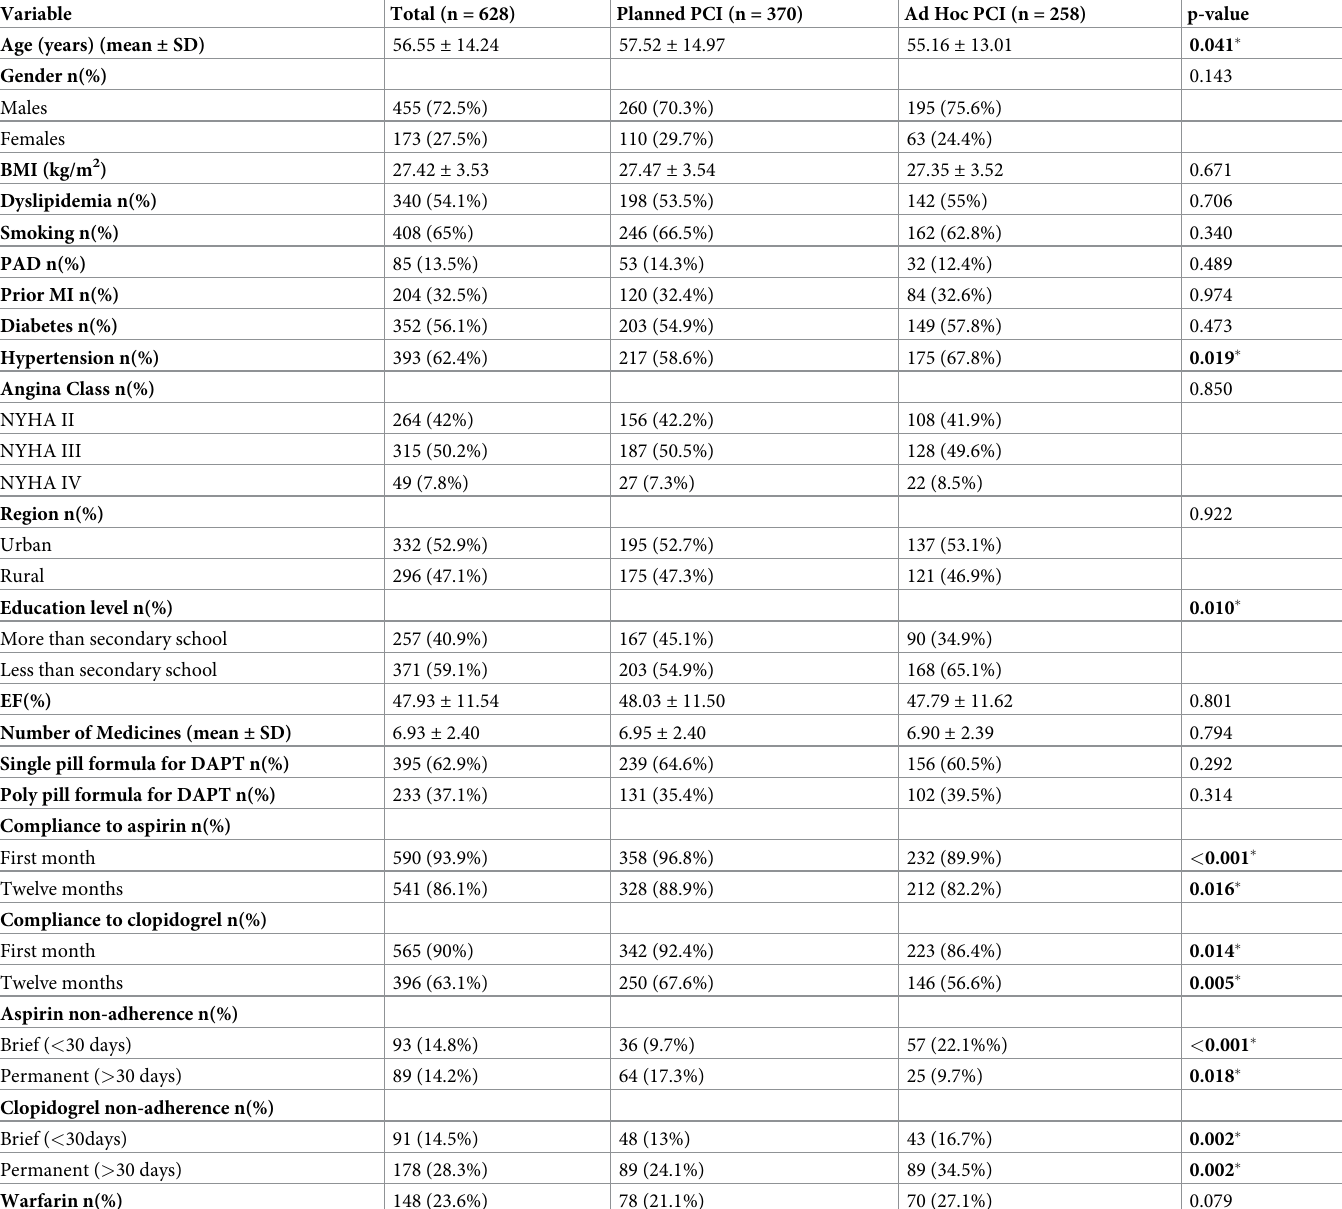
Table 1. Baseline characteristics and compliance in both planned and ad hoc PCI